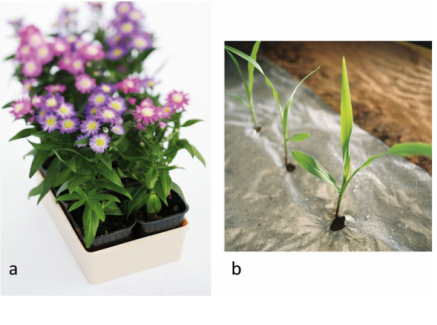
Figure 7. Examples of biodegradable materials: ( a ) plant pot ( © Limagrain) and ( b ) mulching film ( ©